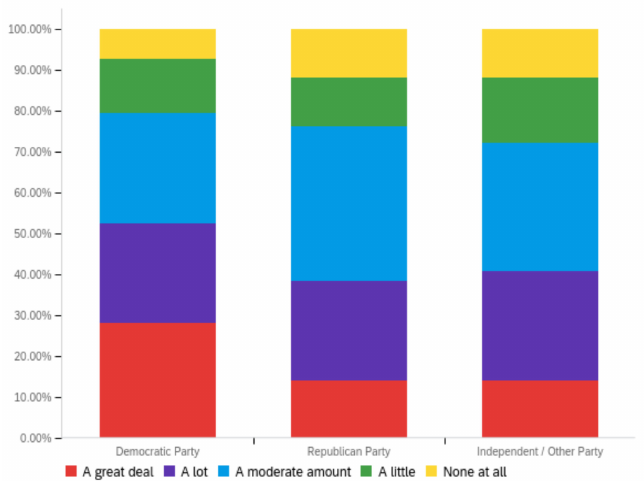
Figure 5. Article sponsor—others’ perception impact by political